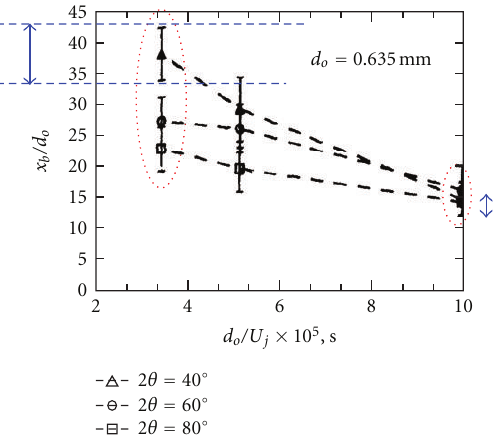
Figure 28: This figure shows sheet break-up length for an impinging injector as a function of instability parameter at three di ff erent impingement included angles. Much higher sensitivity of the sheet break-up length is seen with included angle (2 θ ) at low dn / V ( = d o /U j , in the original article) values. Anderson et al. [57].